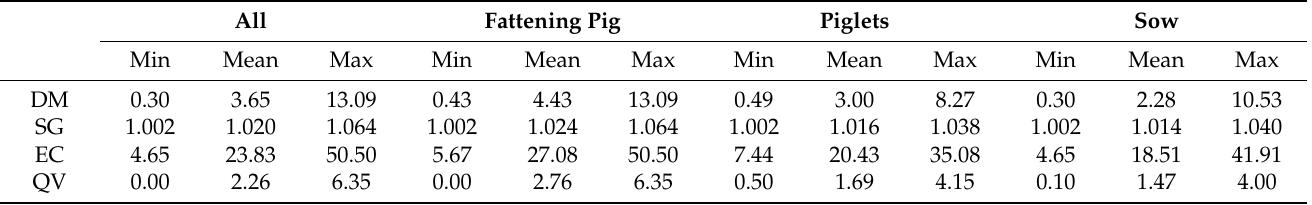
Table 1. Physicochemical slurry properties of “All” (n = 391), “Fattening pig” (n = 232), “Piglet” (n = 49), and “Sow” (n =